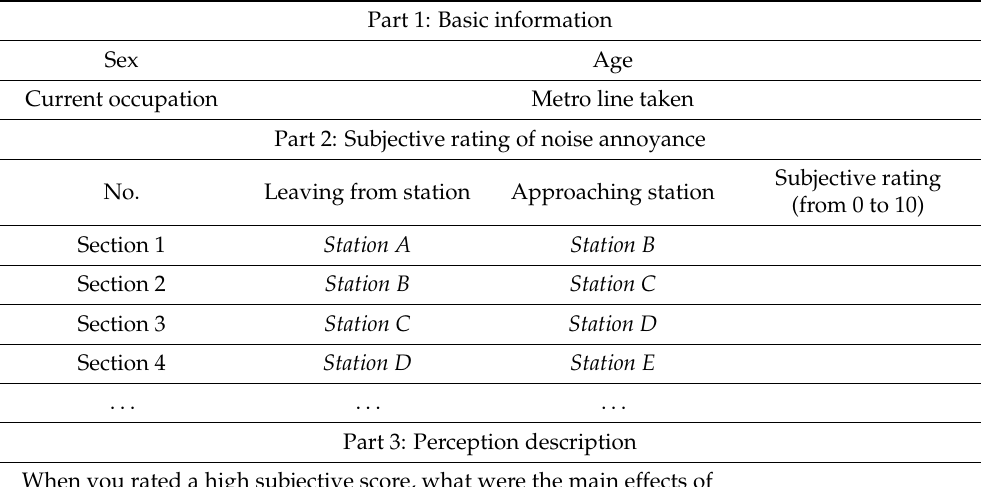
4 of 20 Table 1. Contents of questionnaire. Part 1: Basic information Sex Age Current occupation Metro line taken Part 2: Subjective rating of noise annoyance No.